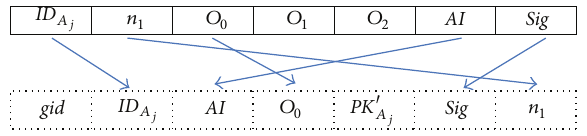
Figure 2: Linkage of messages in on-shelf phase.